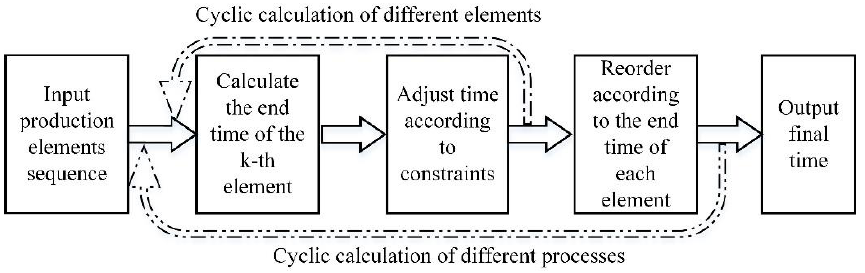
Figure 18. Calculation of the final completion time.